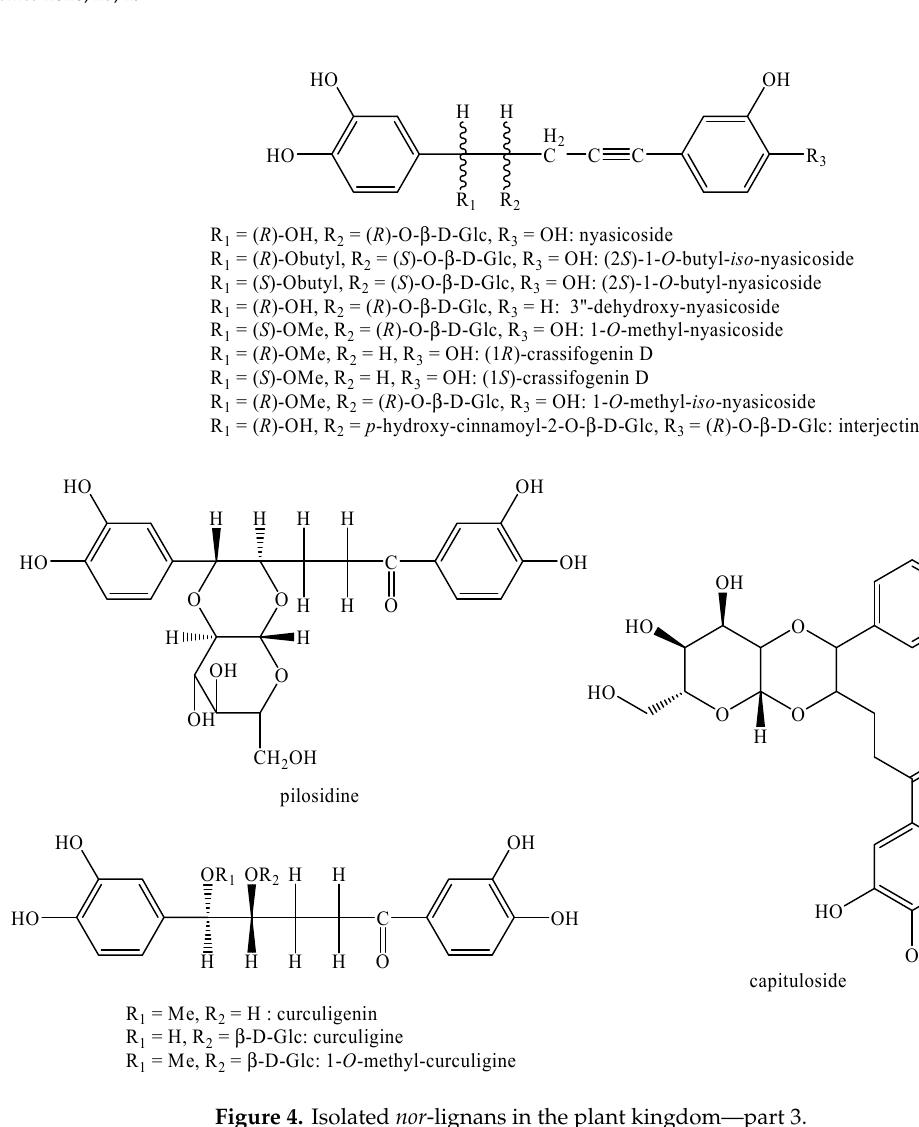
Figure 4. Isolated nor -lignans in the plant kingdom—part 3.